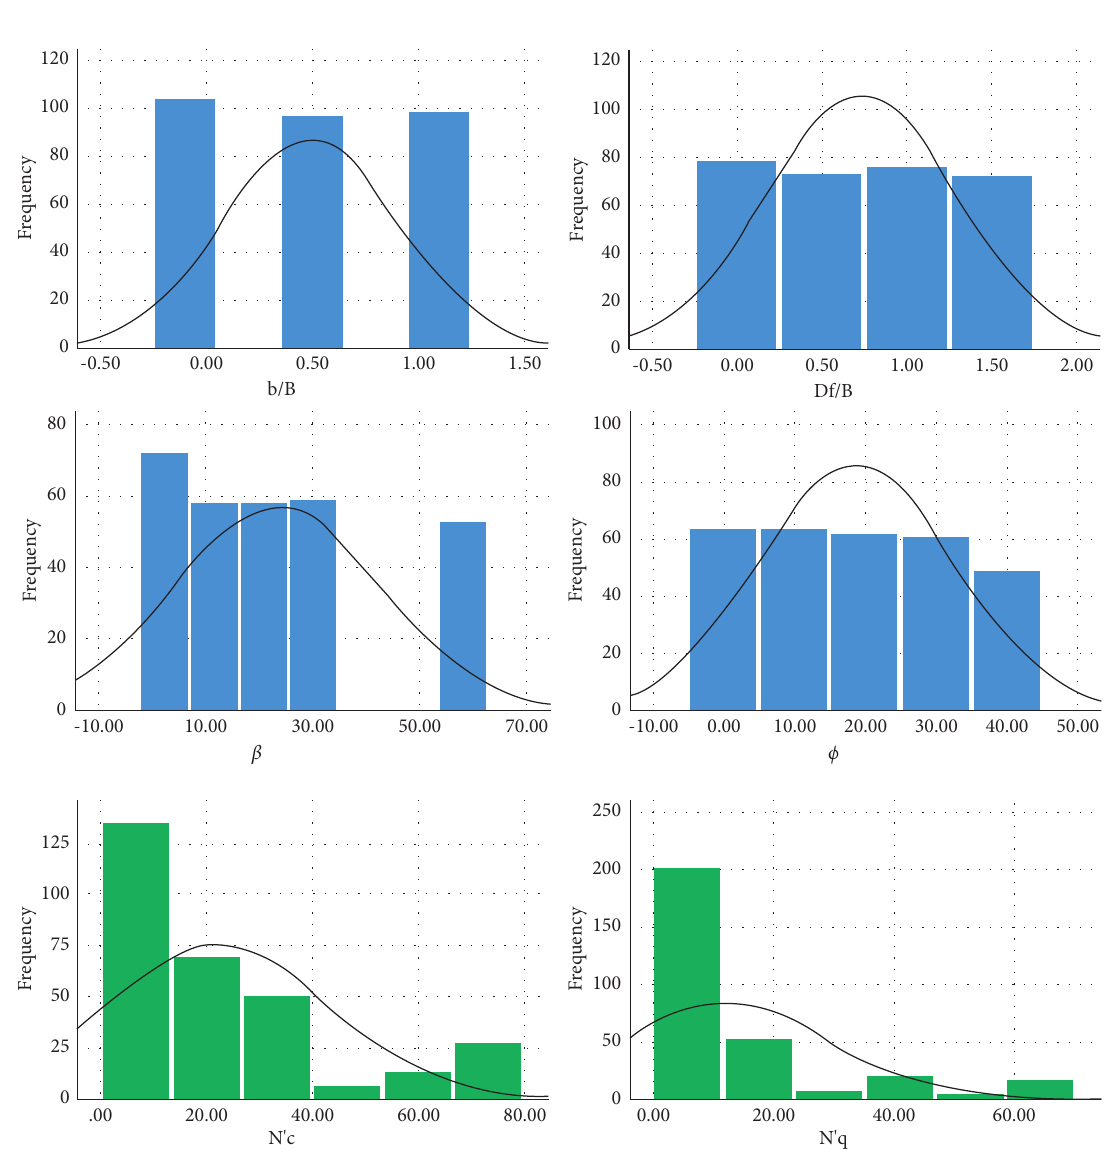
Figure 2: Distribution histograms for inputs (in blue) and outputs (in green).